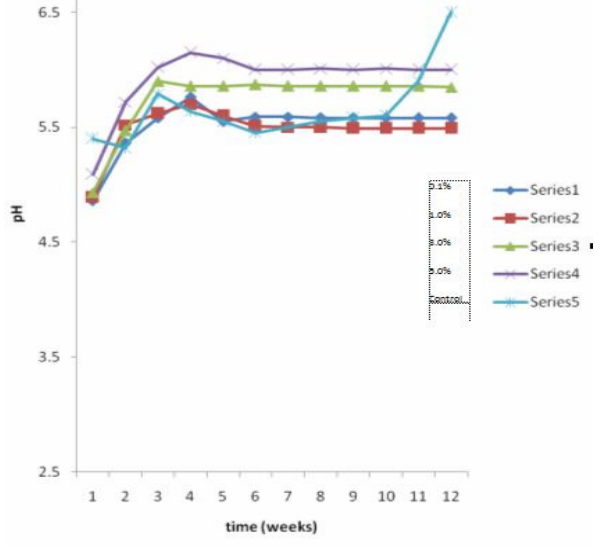
Fig. 5. Changes in the pH of varying concentrations of sodium benzoate preserved powder of mango seed kernels stored at room temperature for 12 weeks. Each reading represents an average of 3